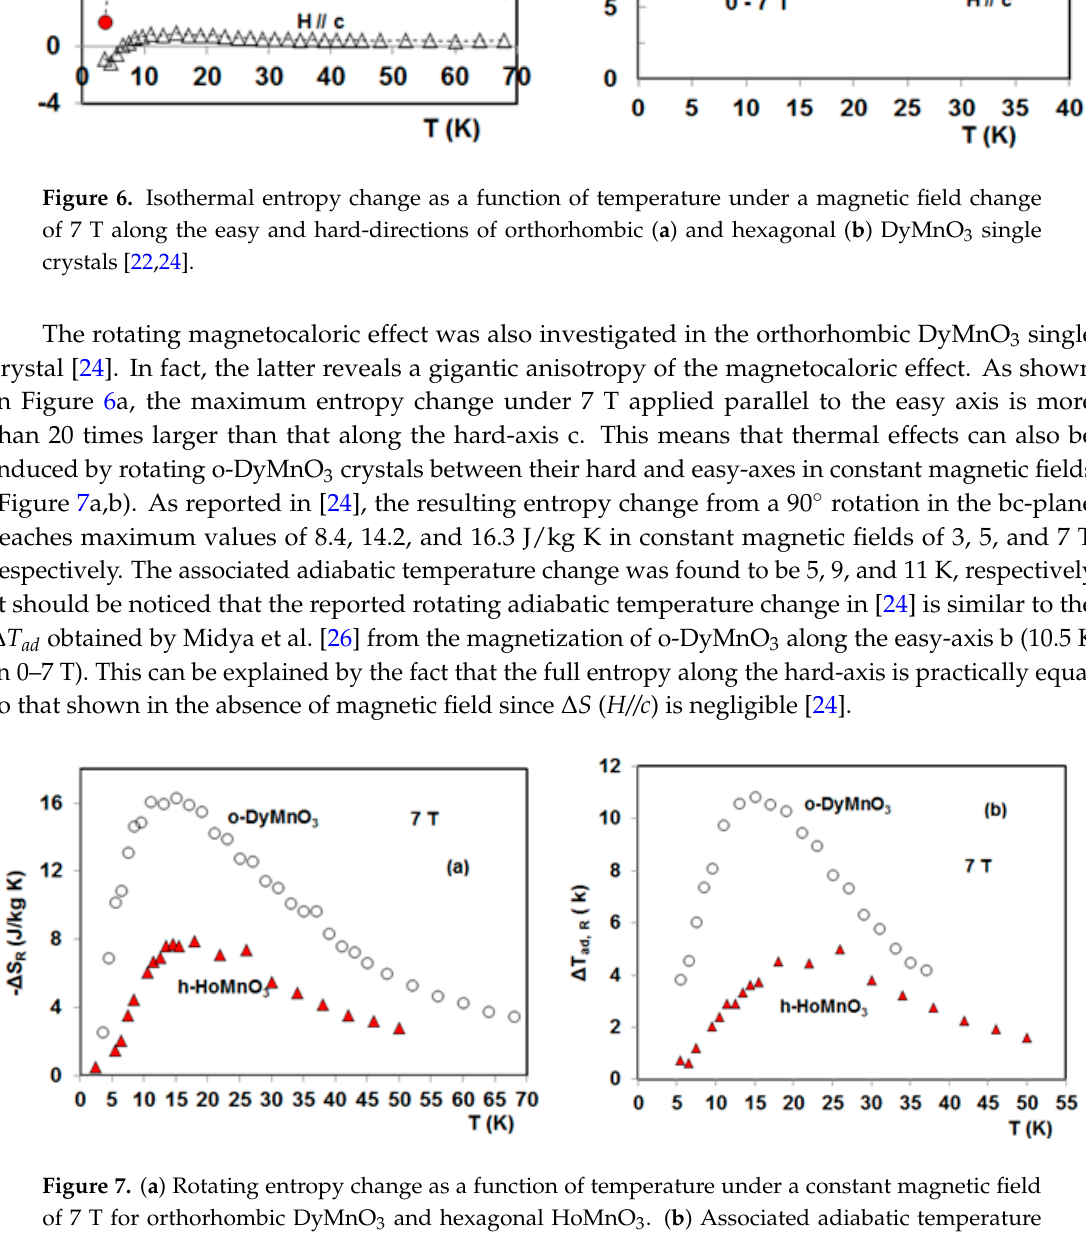
Figure 7. ( a ) Rotating entropy change as a function of temperature under a constant magnetic field of 7 T for orthorhombic DyMnO 3 and hexagonal HoMnO 3 . ( b ) Associated adiabatic temperature change [24,27].